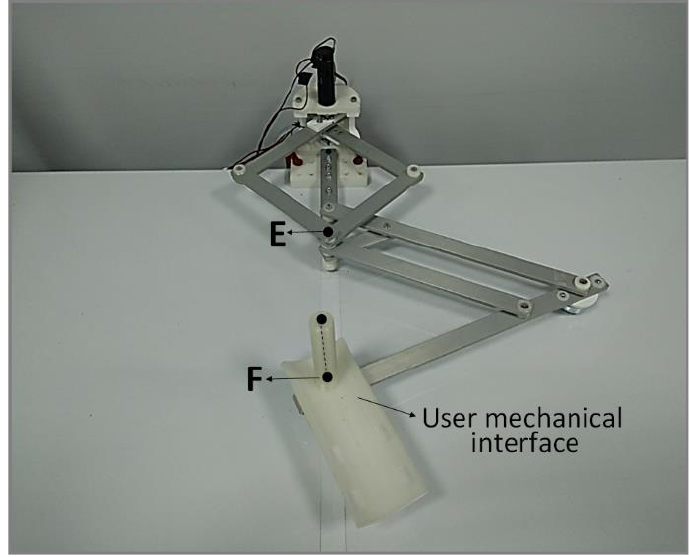
Figure 2. A lab prototype of Nurse device.